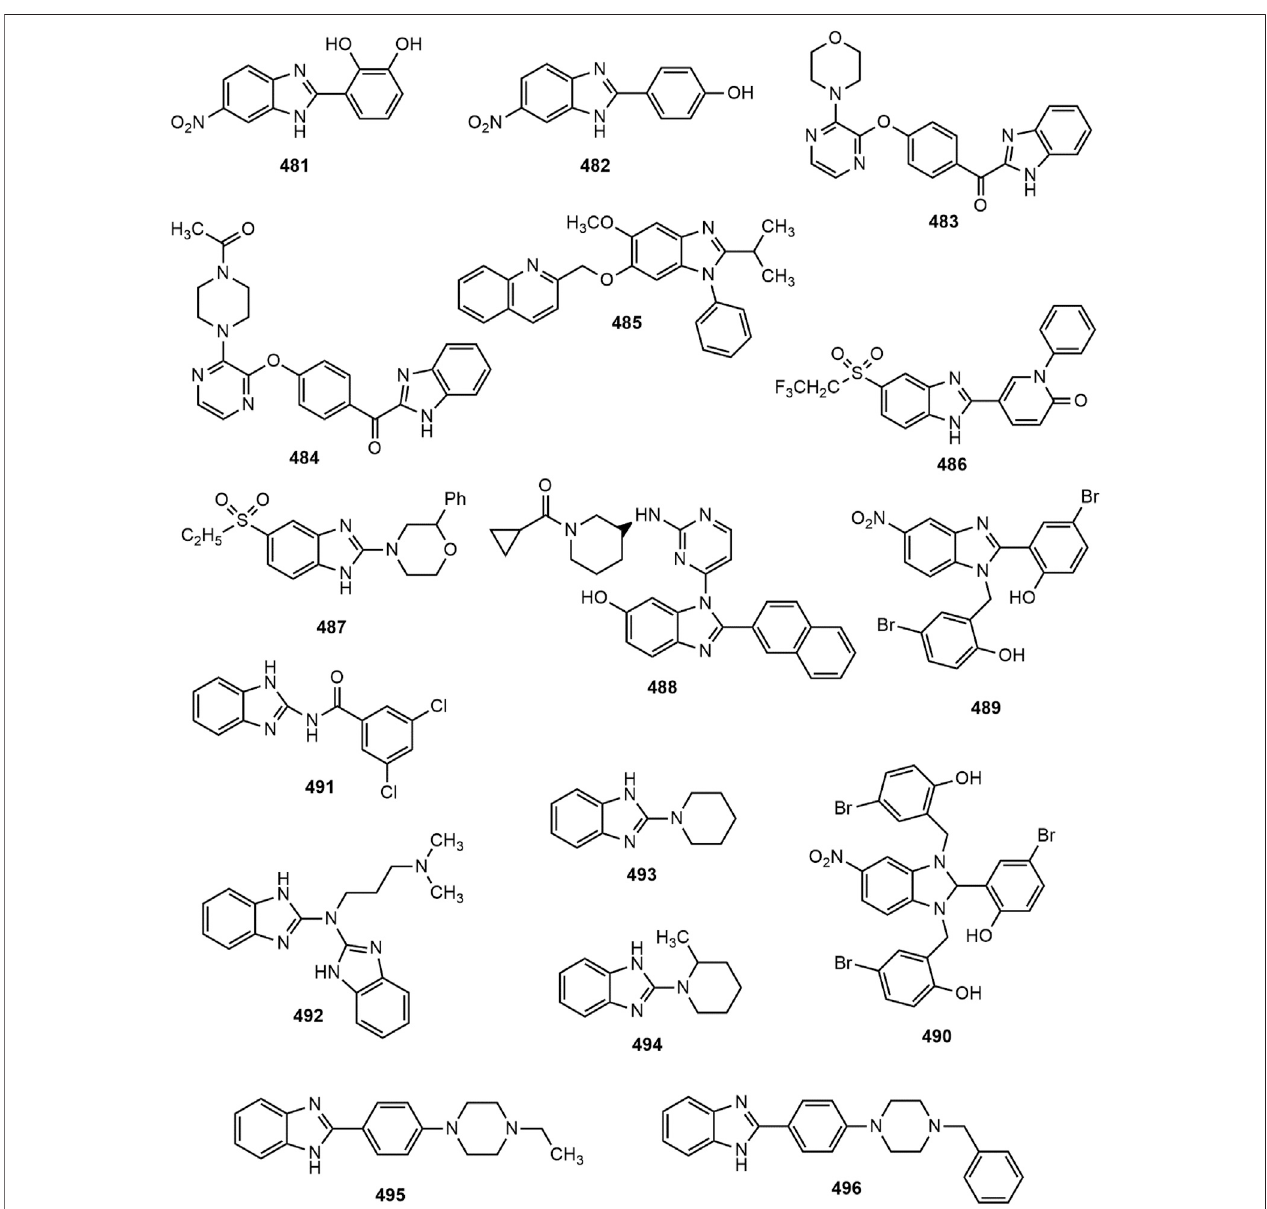
FIGURE 20 | Benzimidazole derivatives as neuro-protective